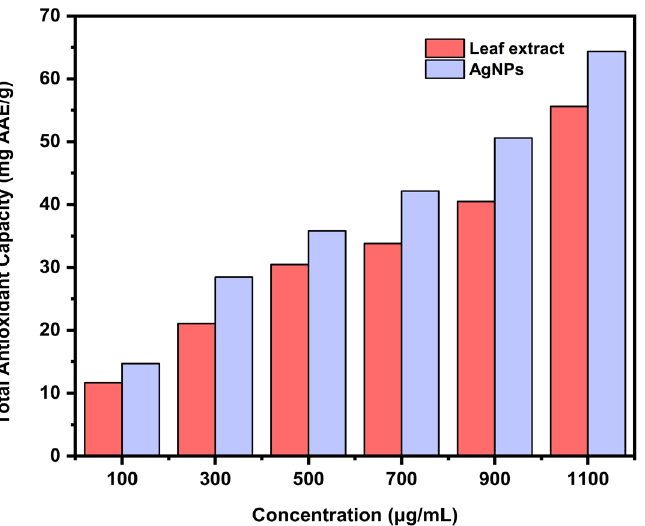
Figure 14. Comparative total antioxidant capacity of aqueous leaf extract and the biosynthesized AgNPs.